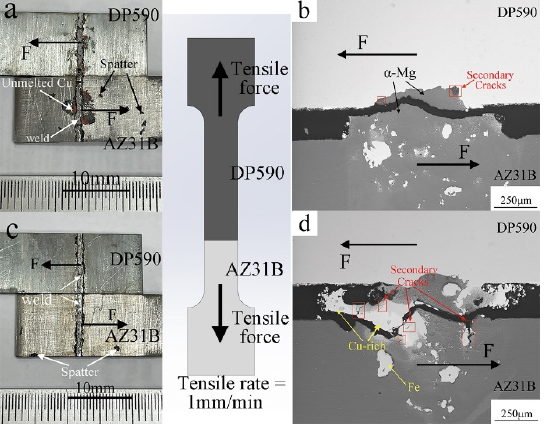
Figure 13. Macroscopic appearance of fracture and cross section display after tensile shearing: ( a ) Cu − 0%Si, ( b ) Cu − 0%Si cross section display, ( c ) Cu − 5%Si, and( d ) Cu − 5%Si cross section display.